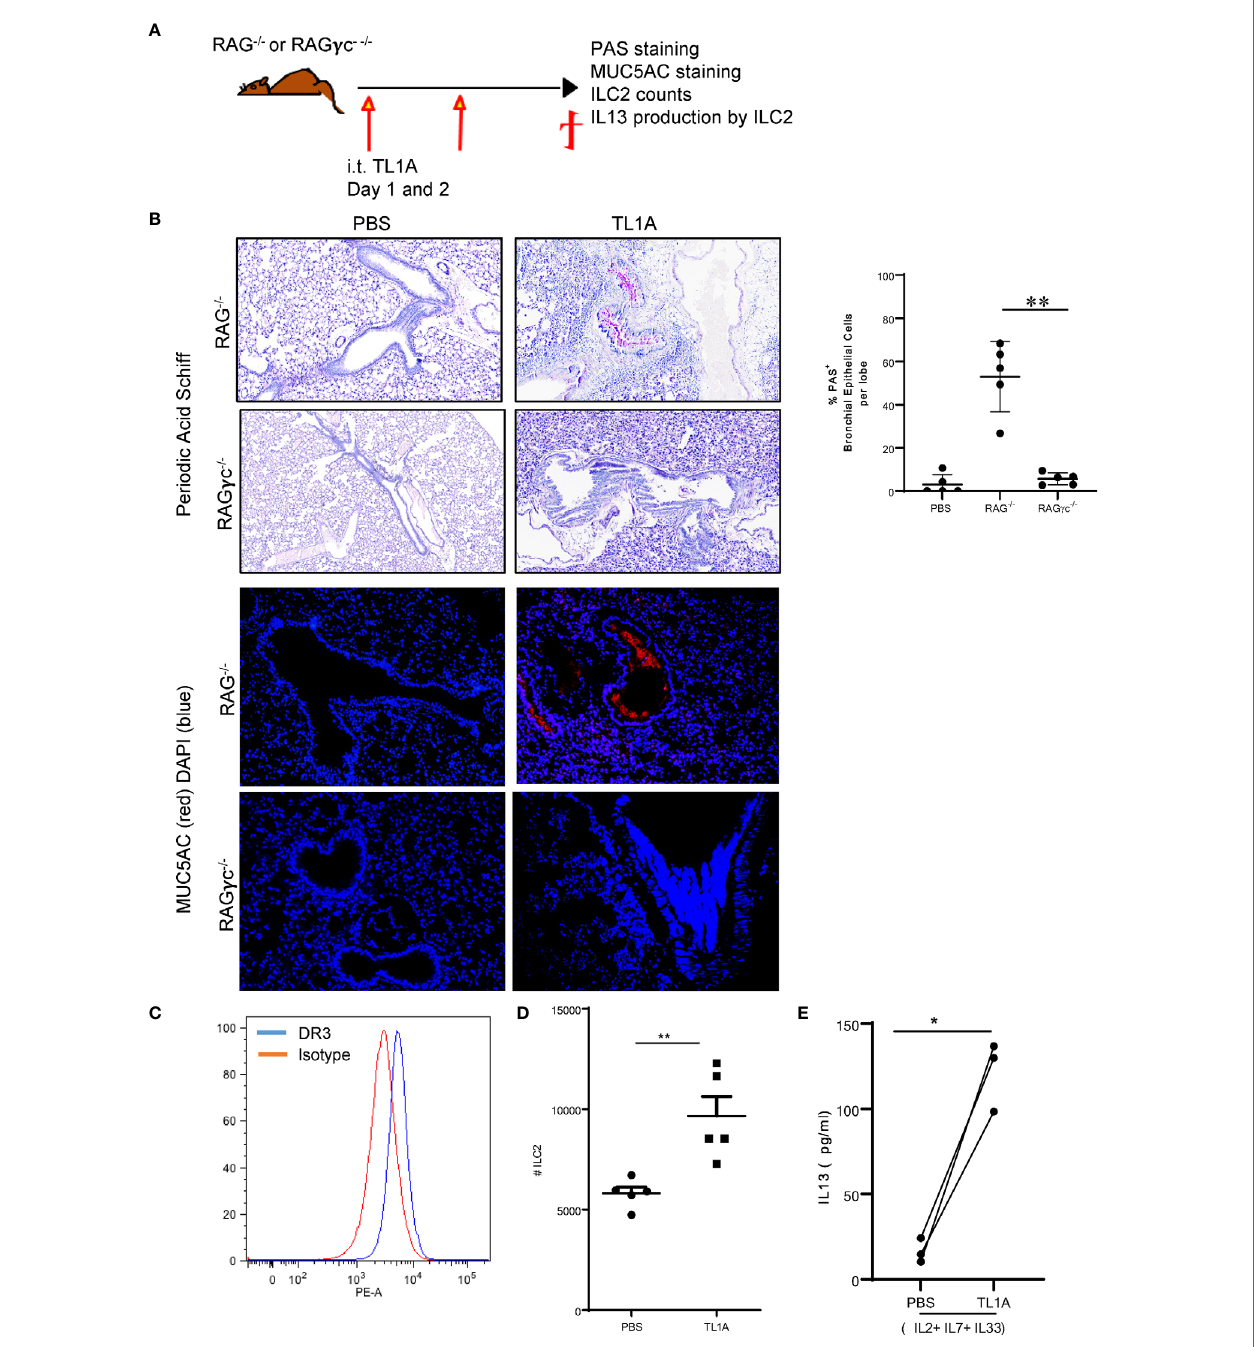
FIGURE 4 | TL1A induces mucus production independently of adaptive immunity, bystander to IL13 production by ILC2. (A) Schematic representation of the protocol used, as previously described in Figure 1 . (B) Top panel: PAS stain of mucus produced in the lungs of RAG -/- and RAG g c -/- mice induced with PBS or TL1A and quanti fi ed using Image Pro Premier (right graph). Lower panels: Immuno fl uorescence stains of MUC5AC (red) and nuclear DAPI (blue). (C) DR3 staining on ILC2 assessed by fl ow cytometry (DR3 in blue and Isotype in red). (D) Number of lung ILC2 in the left lobe of RAG -/- mice induced with TL1A. (E) IL13 levels assessed by ELISA, in the supernatants of ILC2 cultured in the presence of IL2, IL7, and IL33 and stimulated with or without TL1A. All results representative of three experiments with four to six mice per group, or three individual replicate cultures. *p < 0.05, **p <